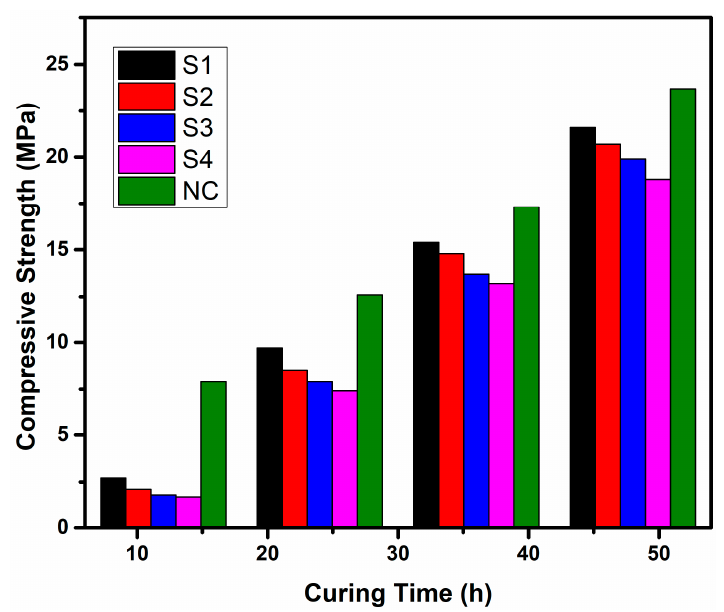
Figure 17. Compressive strength of cement core.